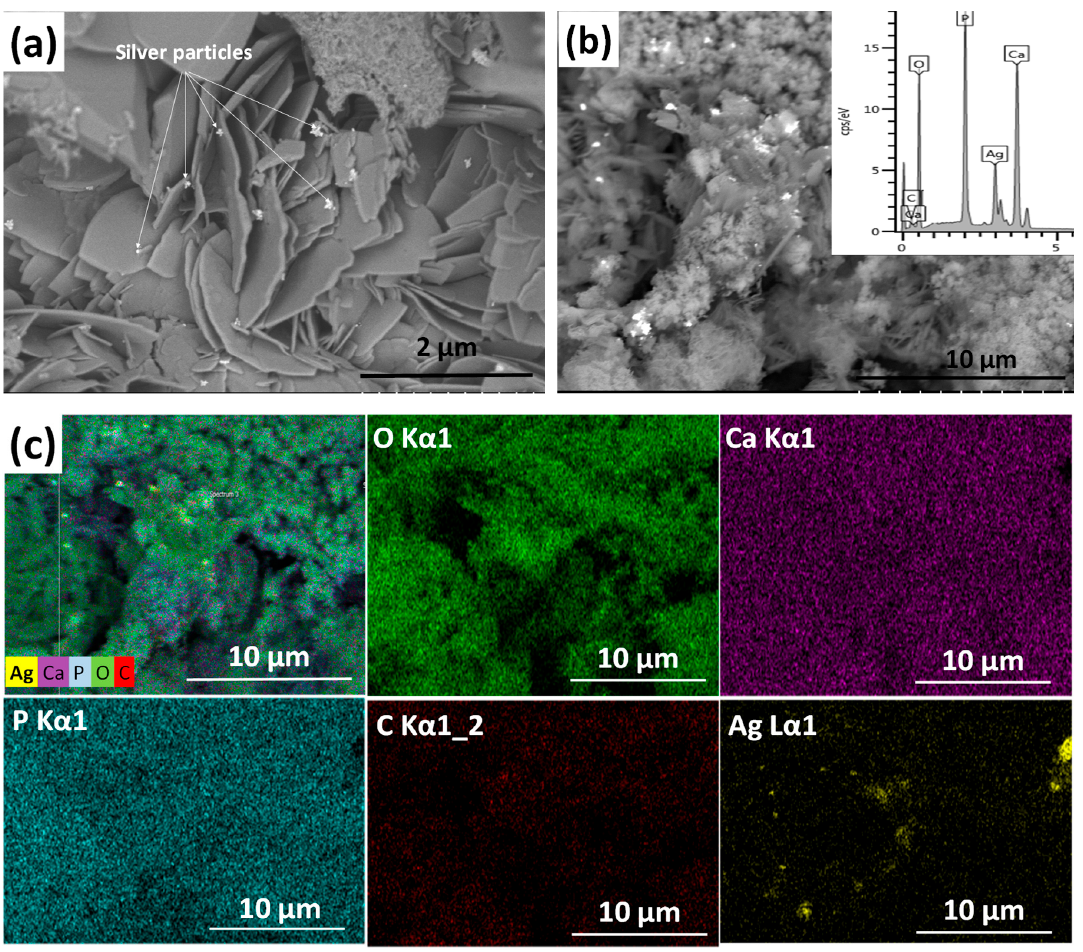
Figure 1. SEM image of silver-containing calcium phosphate (CP) coating. ( a ) Magnification: 20.0 k,